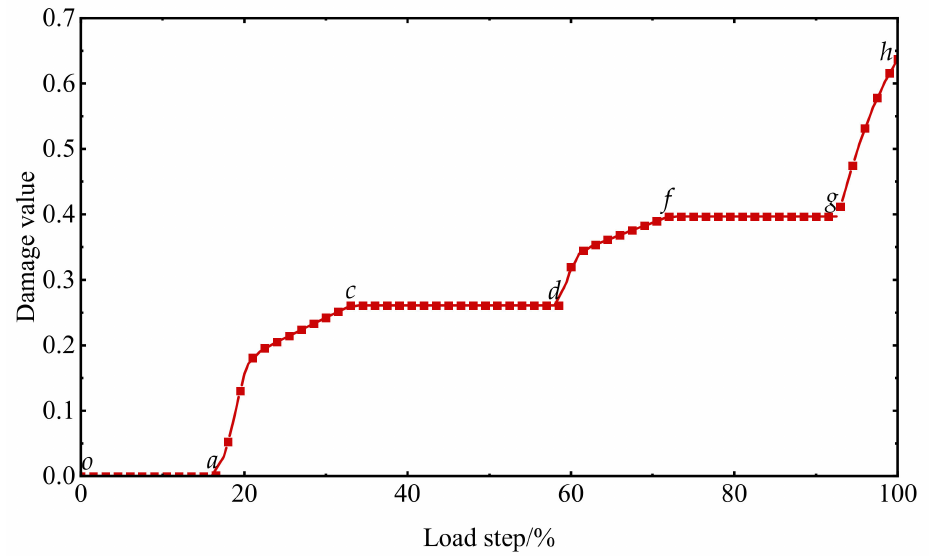
Figure 16. Damage history under uniaxial reciprocating loading: the letters o , a , c , d , f , g , h are the positions of the corresponding points in Figure 15 during the damage